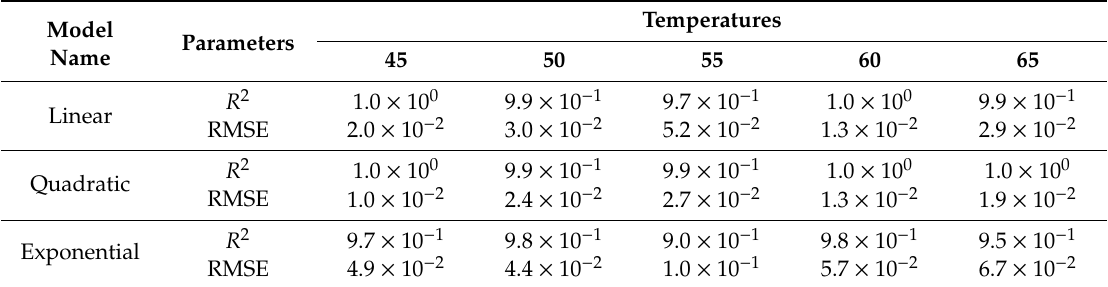
Table 6. Statistical coe ffi cients ( R 2 , RMSE) of the shrinkage models.